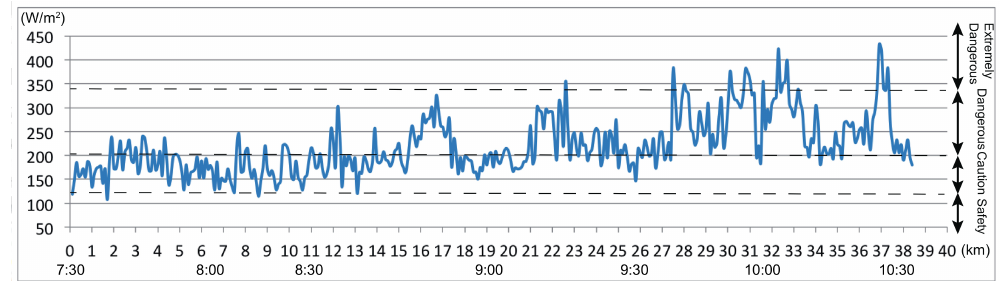
Figure 4. Energy budget for August 9, 2016 graphed as a function of